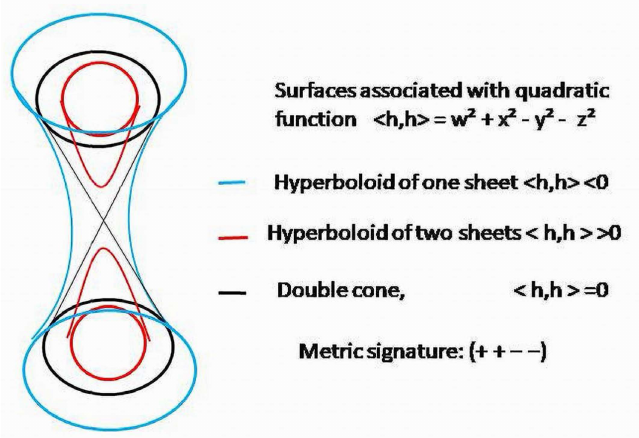
Figure 10. Quadratic form as an expression for potential energy associated with a biologic system. Three-dimensional surfaces are projections on R 3 .